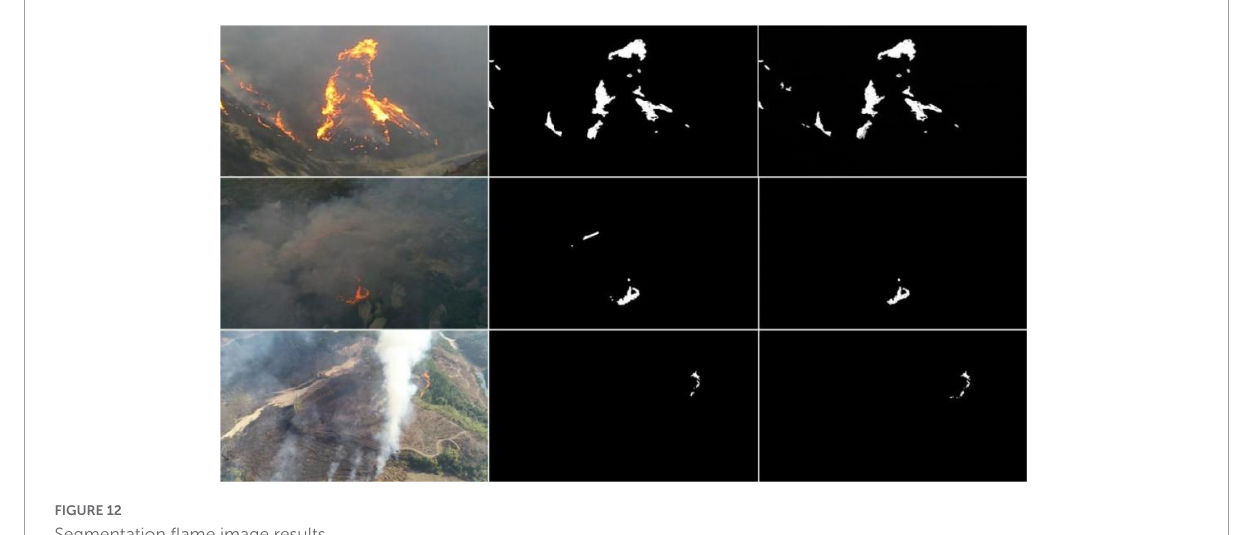
FIGURE12 Segmentation flame image results.